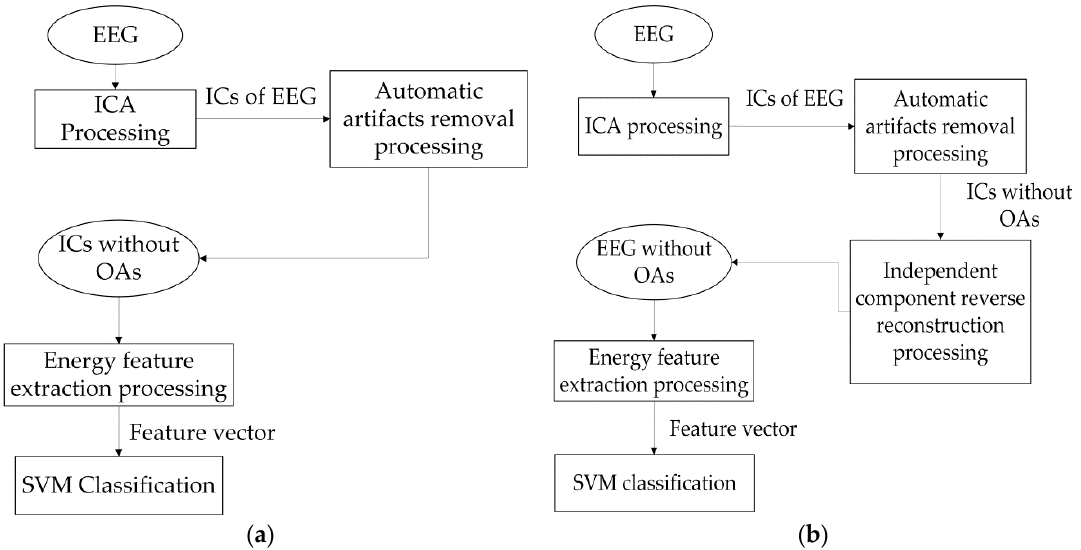
Figure 7. Implementation of Method 3 ( a ) and Method 4( b ).